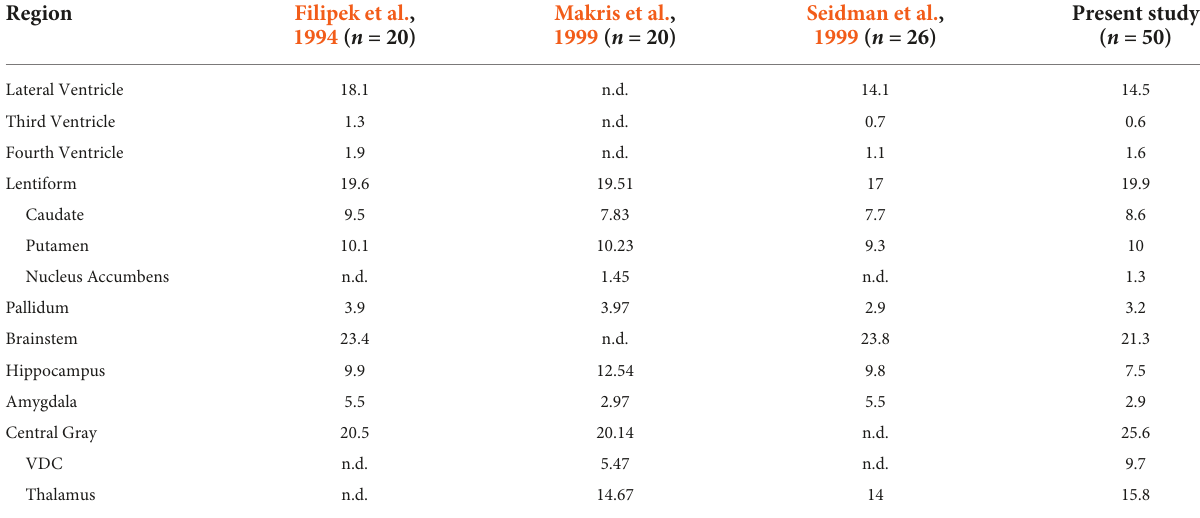
TABLE 3 Comparison of subcortical structural volume estimates from Center for Morphometric Analysis (CMA) studies.